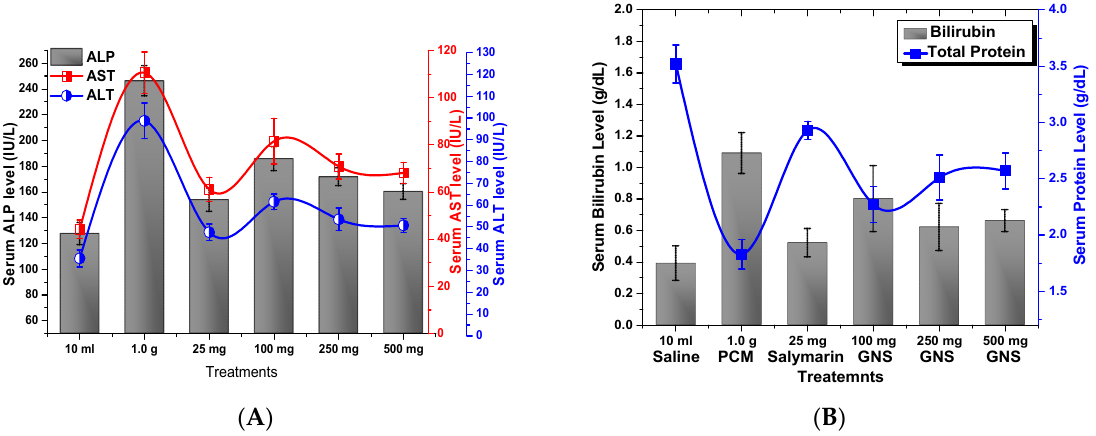
Figure 11. Hepato-protective effect of various doses of REEW-GNs and silymarin in acetaminophen (paracetamol) intoxicated mice. Values represent mean effect ± SEM of n = 6, serum ALP, AST, and ALT level (IU/L) ( A ), bilirubin and total protein level (g/dL) ( B ), statistically significant differences at p ˂ 0.05.